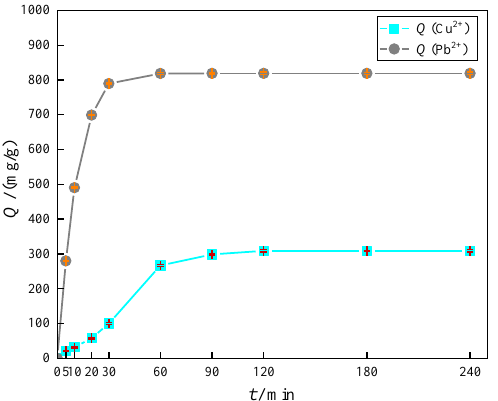
Figure 13. Competitive adsorption of Cu( Ⅱ ) and Pb( Ⅱ ) on MOMMC.